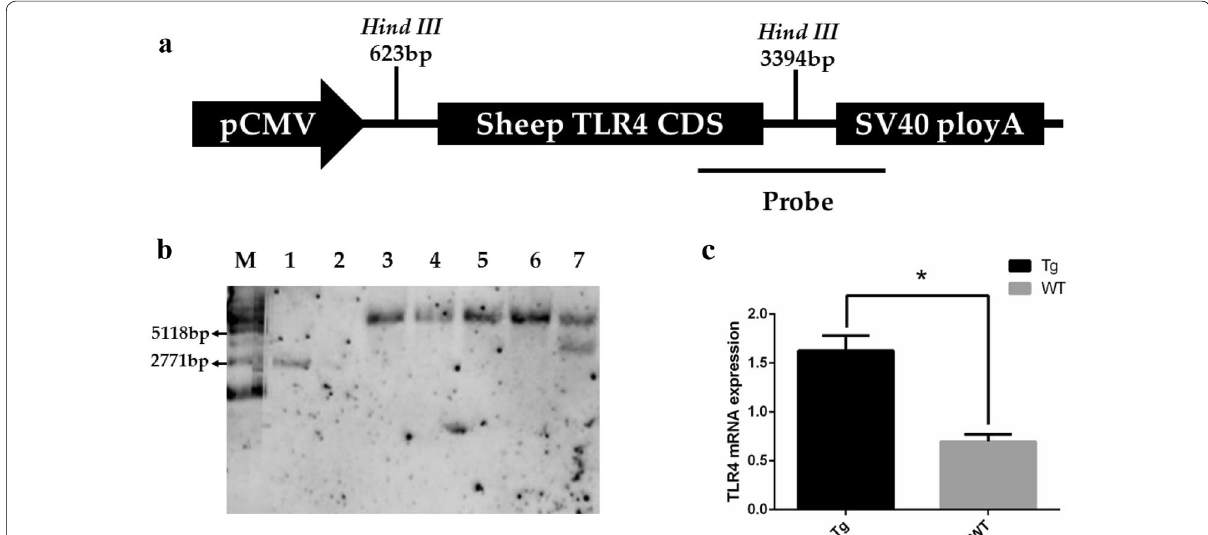
Fig. 1 Production and screening of TLR4 -overexpressing sheep. a The TLR4 expression vector. Ovine TLR4 CDS was inserted into the p3S-LoxP vector, which possessed the promoter CMV and SV40 polyA. The probe for Southern blot was used to screen the TLR4 -overexpressing sheep. b The Southern blot analysis for the DNA sample from the TLR4 expression vector and the ovine ear tissue. Lane 1 is 5 vector, Lane 2 is a 1 sample of the TLR4 expression vector, Lanes 3–6 are WT individuals, and Lane 7 is a Tg ( TLR4 -overexpressing) individual. c The × mRNA expression of TLR4 in peripheral blood mononuclear cells quantified with real-time PCR